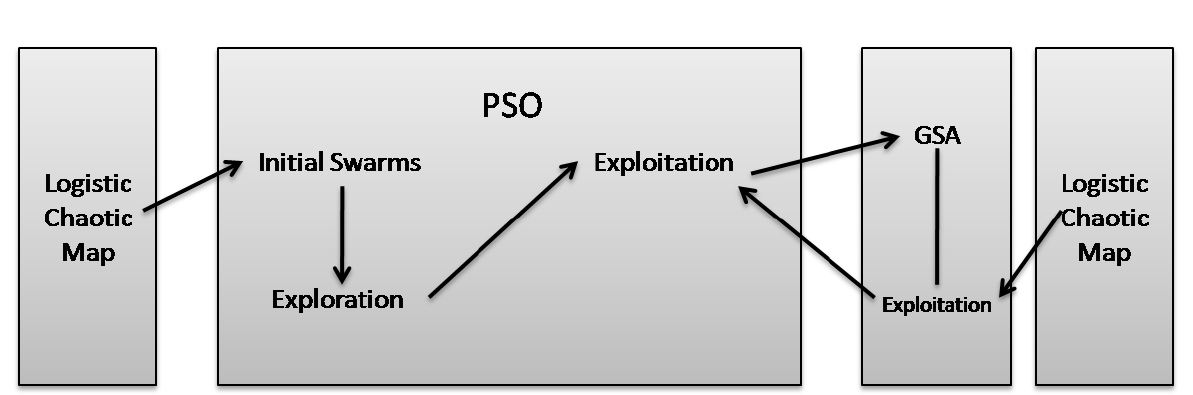
Figure 4. Low level hybrid process of PSO, chaotic mapping and GSA